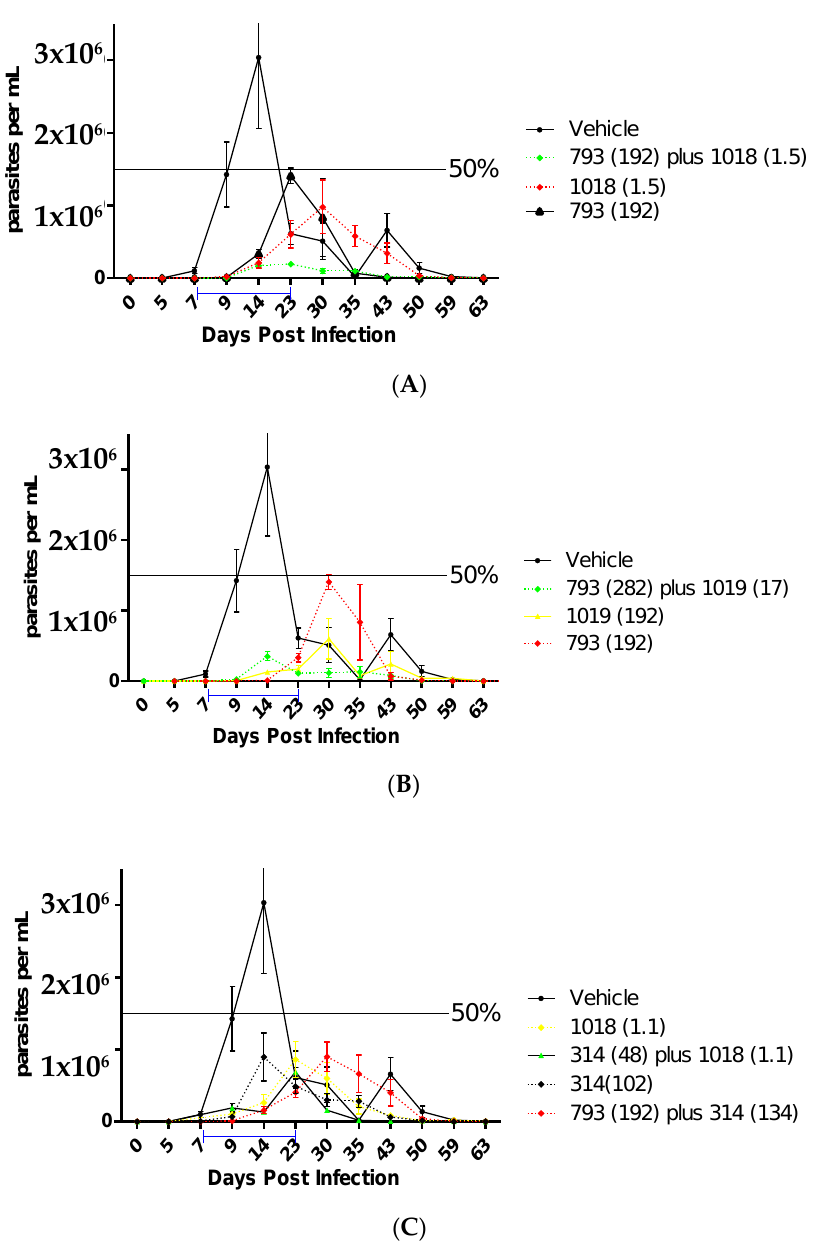
Figure 4. In vivo studies analyzing polypharmacology, using a murine model of Chagas disease. ( A ) Combination of 793 at 192 µmol/kg b.w./day with 1018 at 1.5 µmol/kg b.w./day for 14 days. ( B ) Combination of 793 at 282 µmol/kg b.w./day with 1019 at 17 µmol/kg b.w./day. ( C ) Combination of 314 at 134 µmol/kg b.w./day with 793 at 192 µmol/kg b.w./day and 314 at 48 µmol/kg b.w./day with 1018 at 1.1 µmol/kg b.w./day. The blue bar indicates the treatment period. The colors of the plot indicate the grade of efficacy (green as good, yellow as medium, and red as low). The doses used are indicated in µmol/kg b.w./day in parentheses for each compound. Table 5. Summary of the in vivo trials. It is showing the most promising results regarding the evaluation of compounds in monotherapy and combinations.